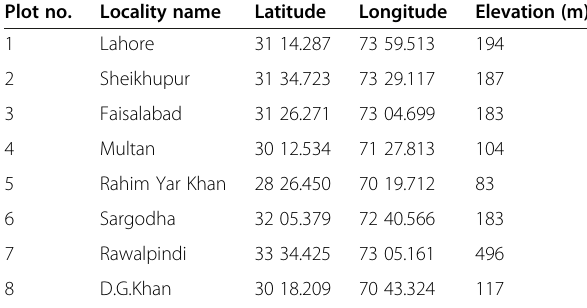
Table 1 GPS positions of the selected localities Plot